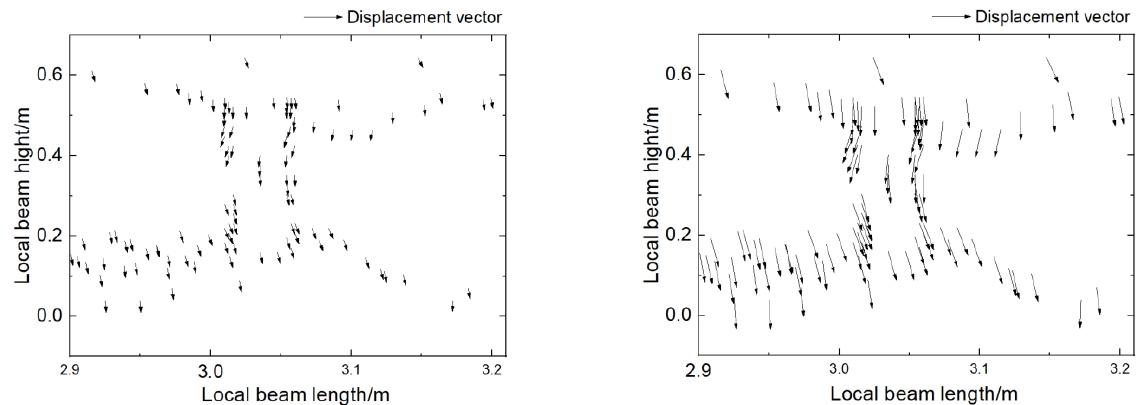
Figure 26. Displacement vector distribution of nos. 13 – 14 damaged member under condition D02.